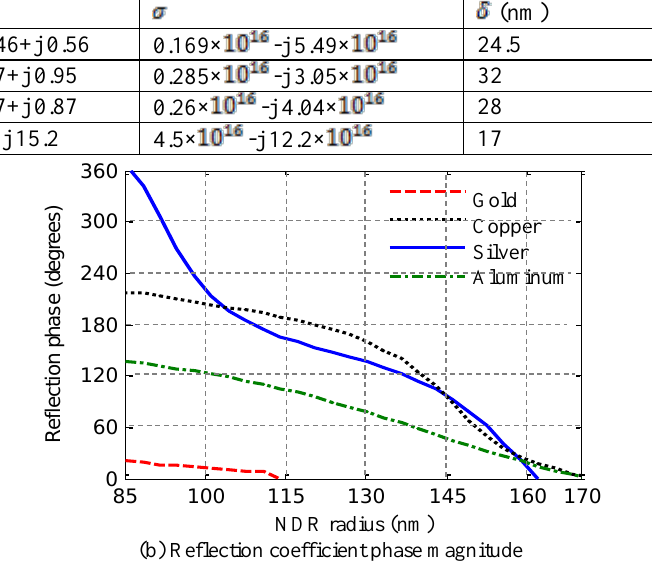
Figure 5 The variations of the reflection coefficient magnitude and phase versus the NDR radius at 474 THz for the unit cell with different plane materials for h =200 nm, L =350 nm and h d =50 nm.